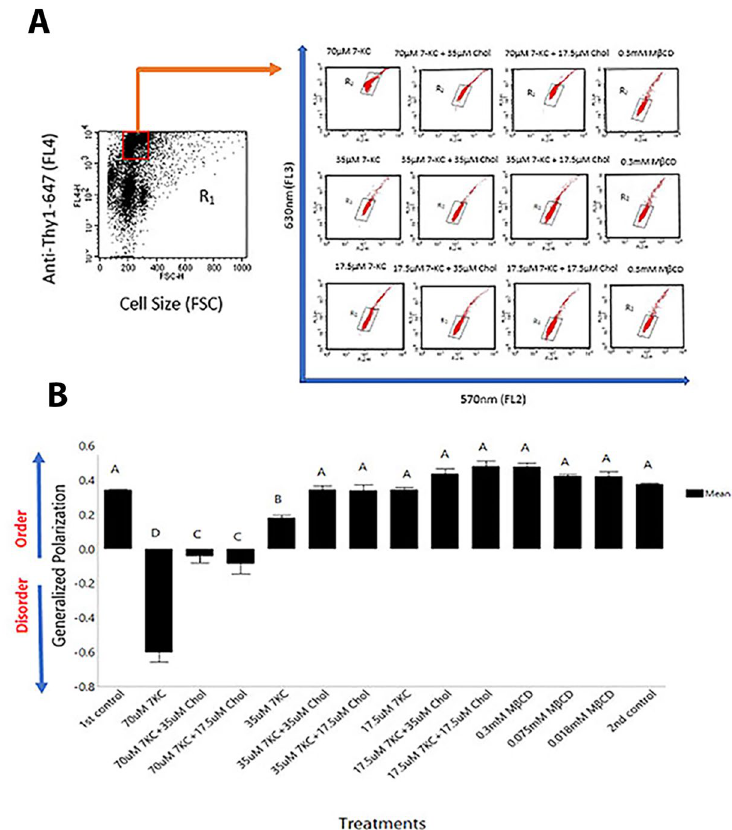
Figure 1. Assessing membrane order and disorder in T cells after staining with di-4 ANEPPDHQ fluorescent dye. Lymph node cells were exposed to di-4 ANEPPDHQ dye and stained with anti-Thy-1 Alexa Fluor 647. Thy- 1-positive T cells were enumerated in 7-KC and/or different concentrations of Cholesterol and MβCD-vehicle control were gated (red box) to enumerate T cell subset. Emission at 570 nm and spectral shift to 630 nm, shown as mean fluorescence indices (MFI) registered in FL2 and FL3 channels, report membrane order and disorder, respectively. Representative experiment dot plots showing ordered (X-axis) and disordered (Y-axis) membrane bearing T cells ( A —upper panel) and quantification of order and disorder as represented by rGP values for different treatment groups ( B —lower panel) is shown. Control samples (not treatment group) were analyzed at the beginning (1st control) and at the end (2nd control) of the experimental run. All data were computed from 5 independent trials. Error bars represent Standard Error. Statistical significance between the groups was computed by two-way ANOVA and post hoc Tukey analysis using JMP program. Groups with dissimilar connecting letters are significantly different from each other. (p <